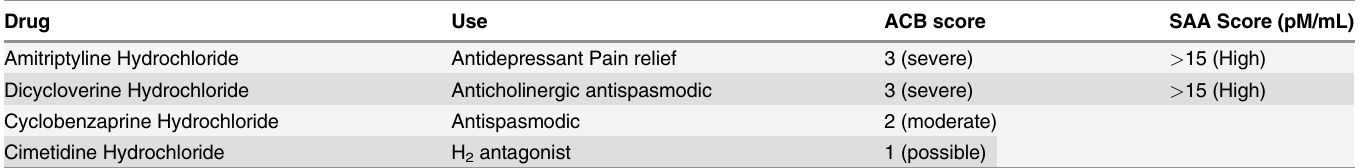
Table 1. The drugs employed in the present investigation with their respective Anticholinergic Cognitive Burden (ACB) scores and Serum Anticholinergic Activity (SAA) scores.